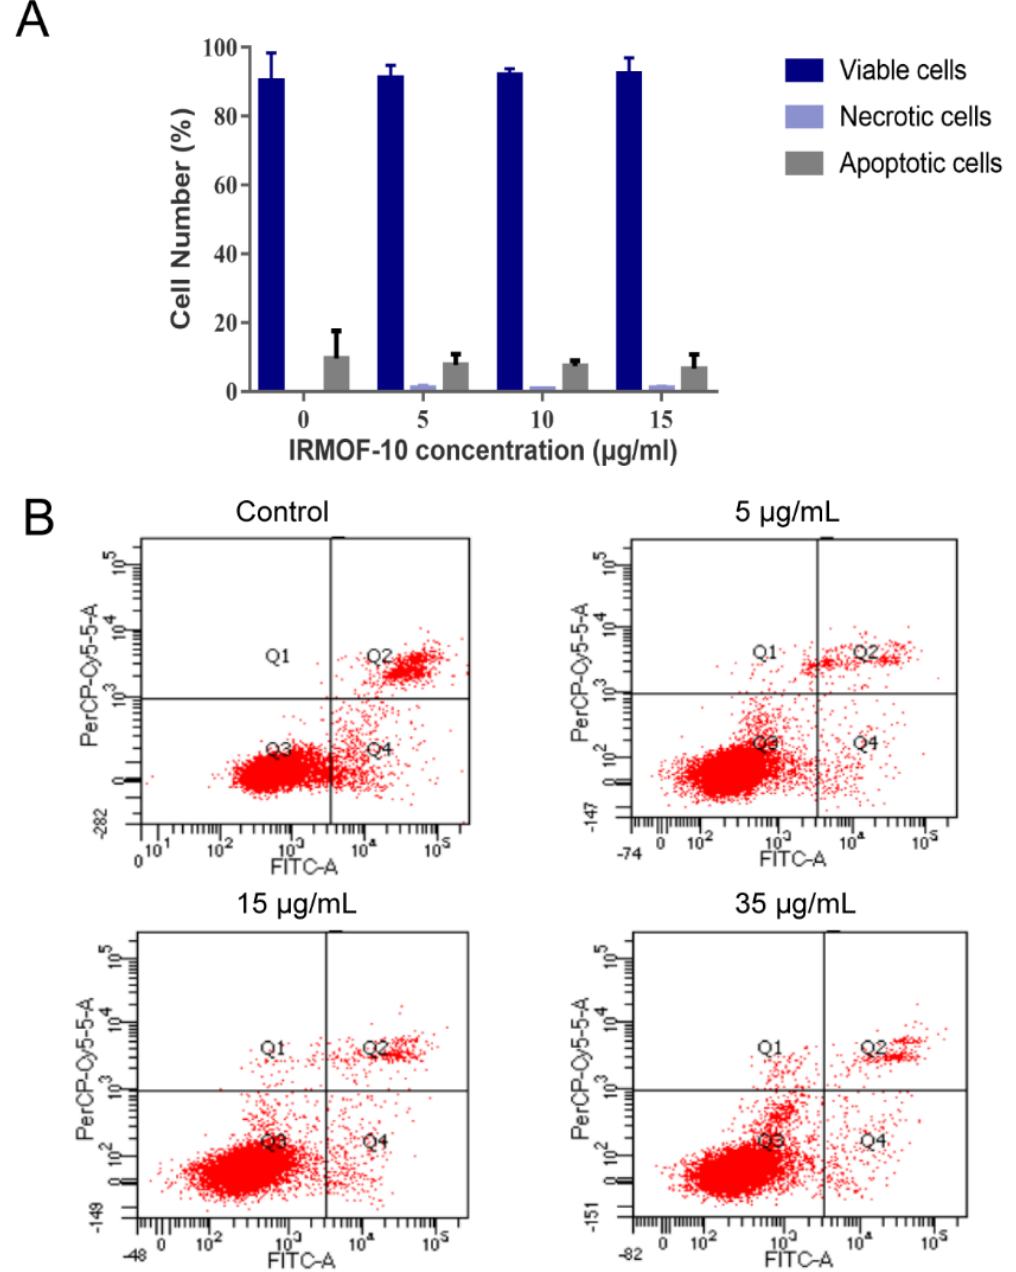
Figure 8. Safety of IRMOF-10: ( A ) proportion of viable, necrotic, and apoptotic HepG2 cells after incubation with different concentrations of IRMOF-10 for 24 h; ( B ) flow cytometry detection of apoptosis with FITC-annexin V/ PI double staining.